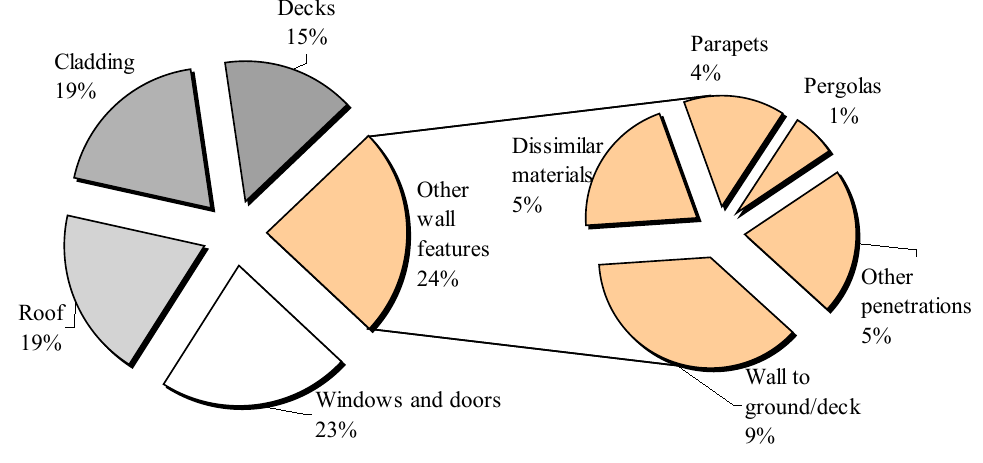
Figure 1. Water entry sites in New Zealand leaking